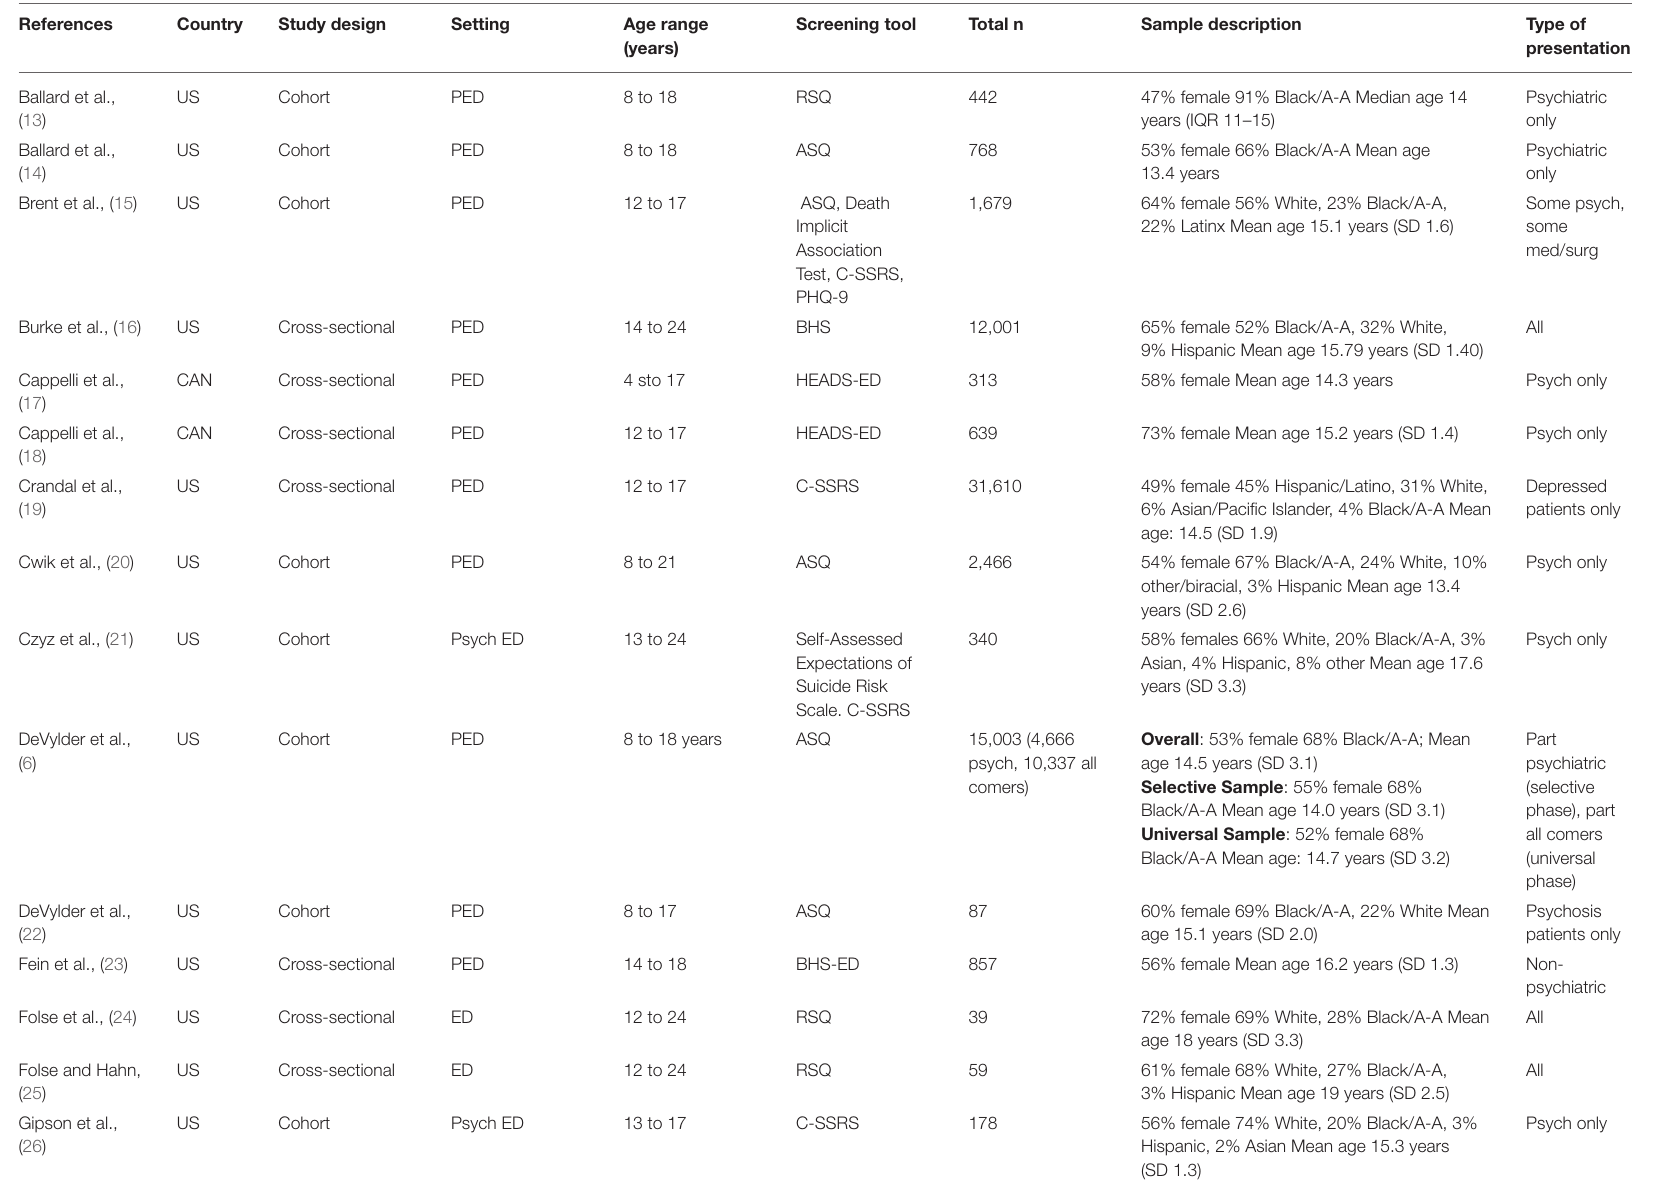
TABLE 1 | Characteristics of included